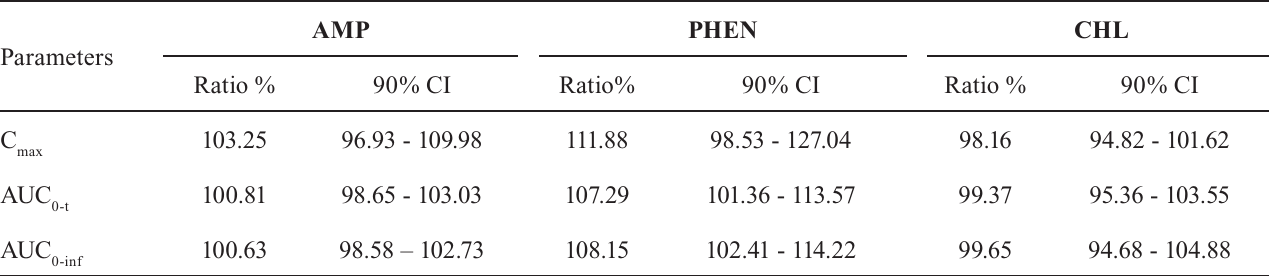
TABLE IV - 90% Confidence intervals for the log-transformed parameters ratio test/reference (n=77)